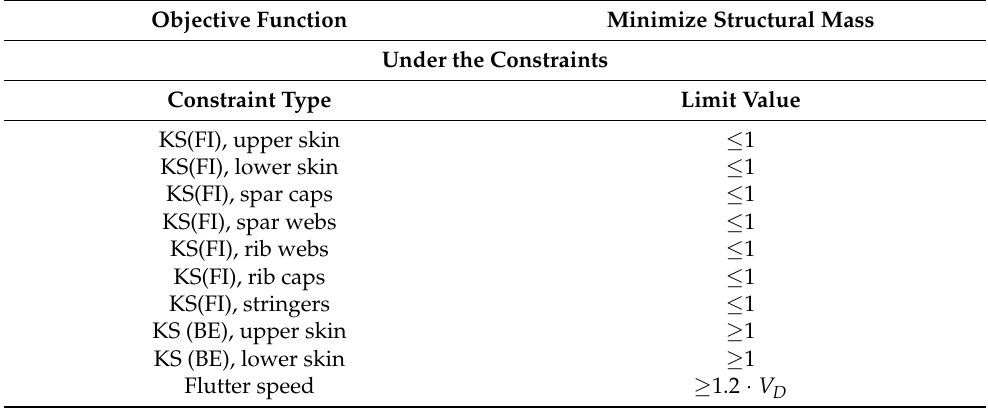
Table 1. Optimization problem